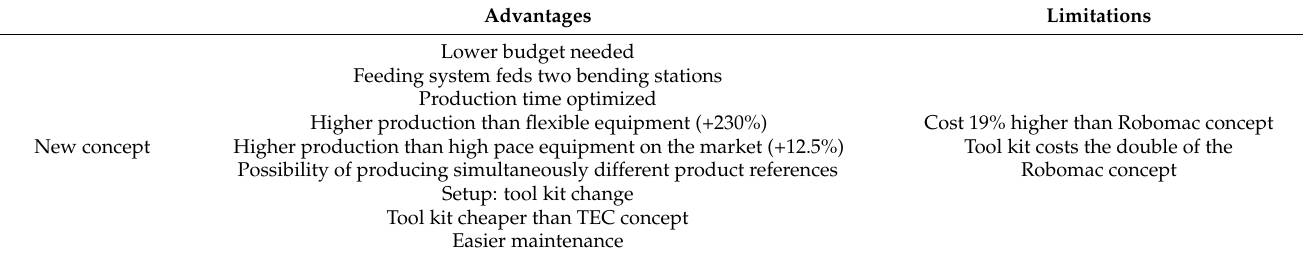
Table 4. Advantages and limitations of the new concept